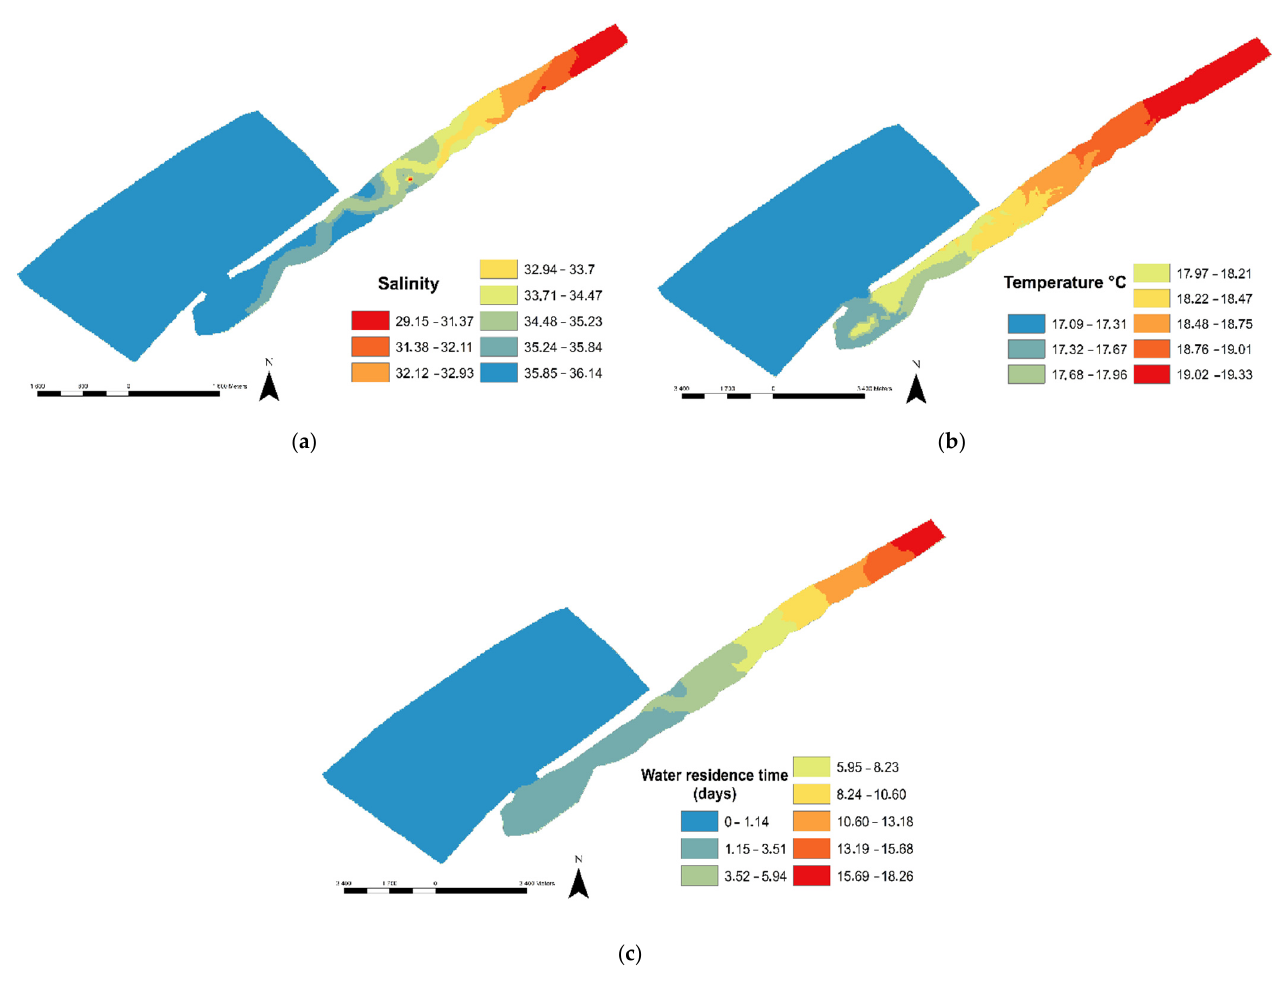
Figure 6. Plots of average modeled physical parameters in Oualidia lagoon for the spring period from February until June 2013. ( a ) Salinity/PSU. ( b ) Temperature/°C. ( c ). WRT/days.